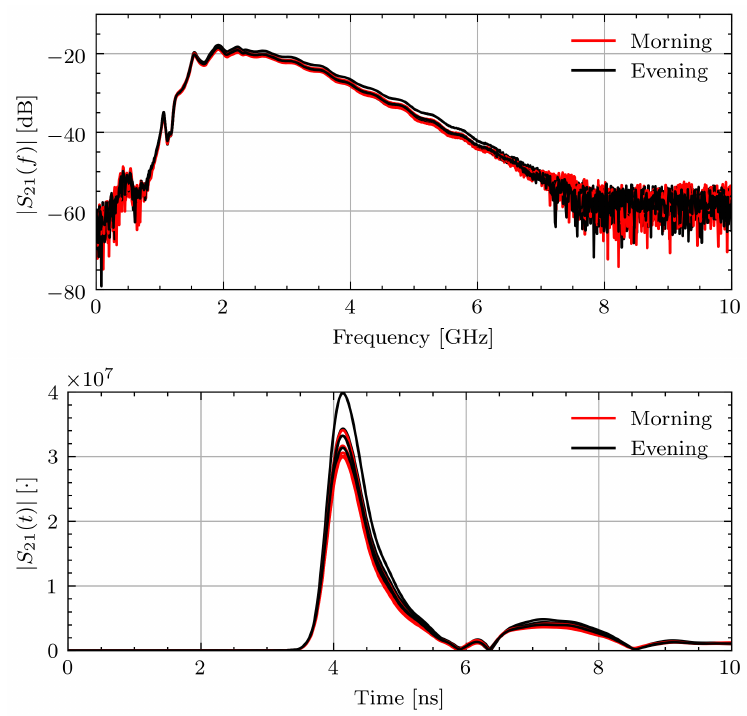
Figure 10. Measured | S 21 ( f ) | and | S 21 ( t ) | signals for Volunteer B on fasting day 3. Figure 11 shows the associated permittivity estimates. The permittivity estimates are consistent within each measurement session.